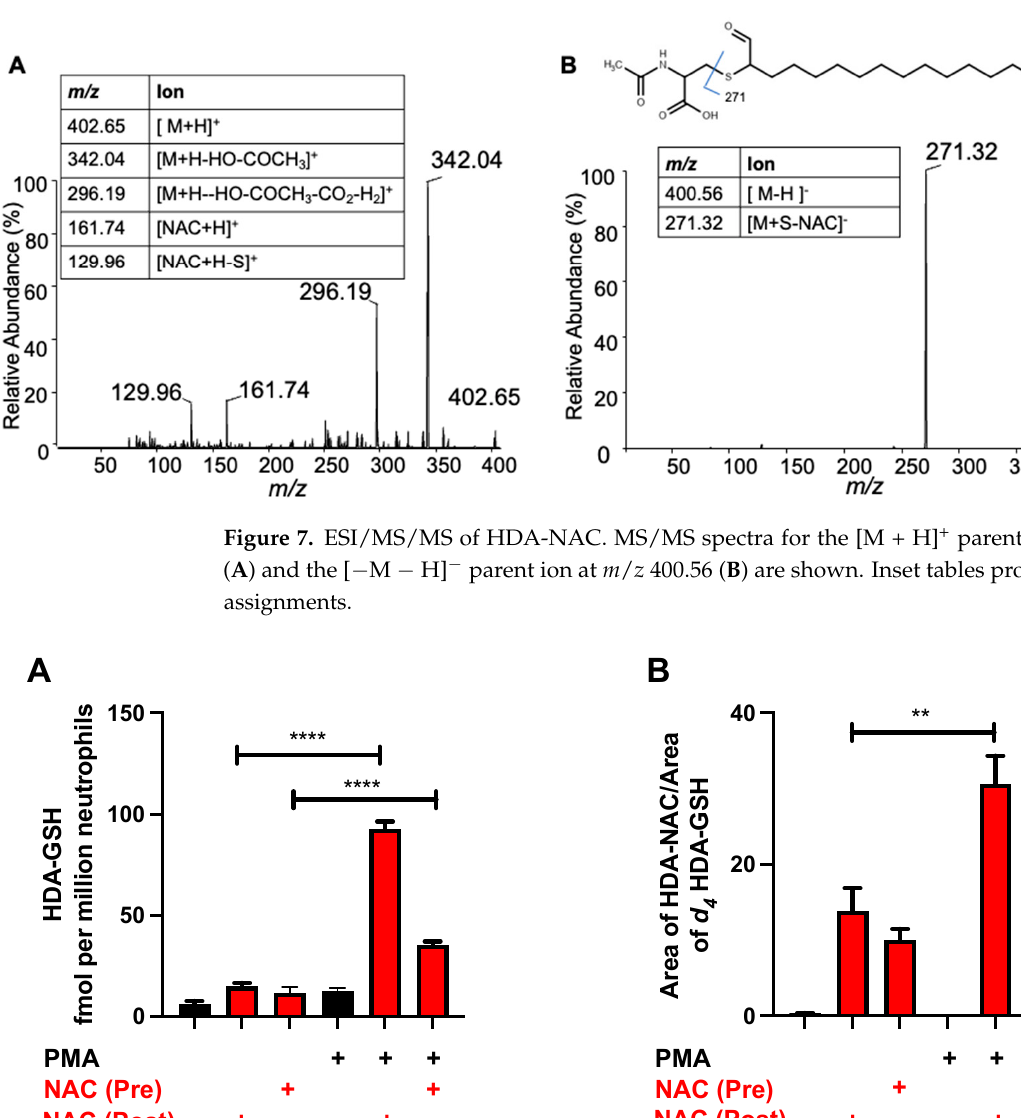
Figure 7. ESI/MS/MS of HDA-NAC. MS/MS spectra for the [M + H] + parent ion at m/z 402.65 ( A ) and the –M − H] − parent ion at m/z 400.56 ( B ) are shown. Inset tables provide fragment ion assignments.